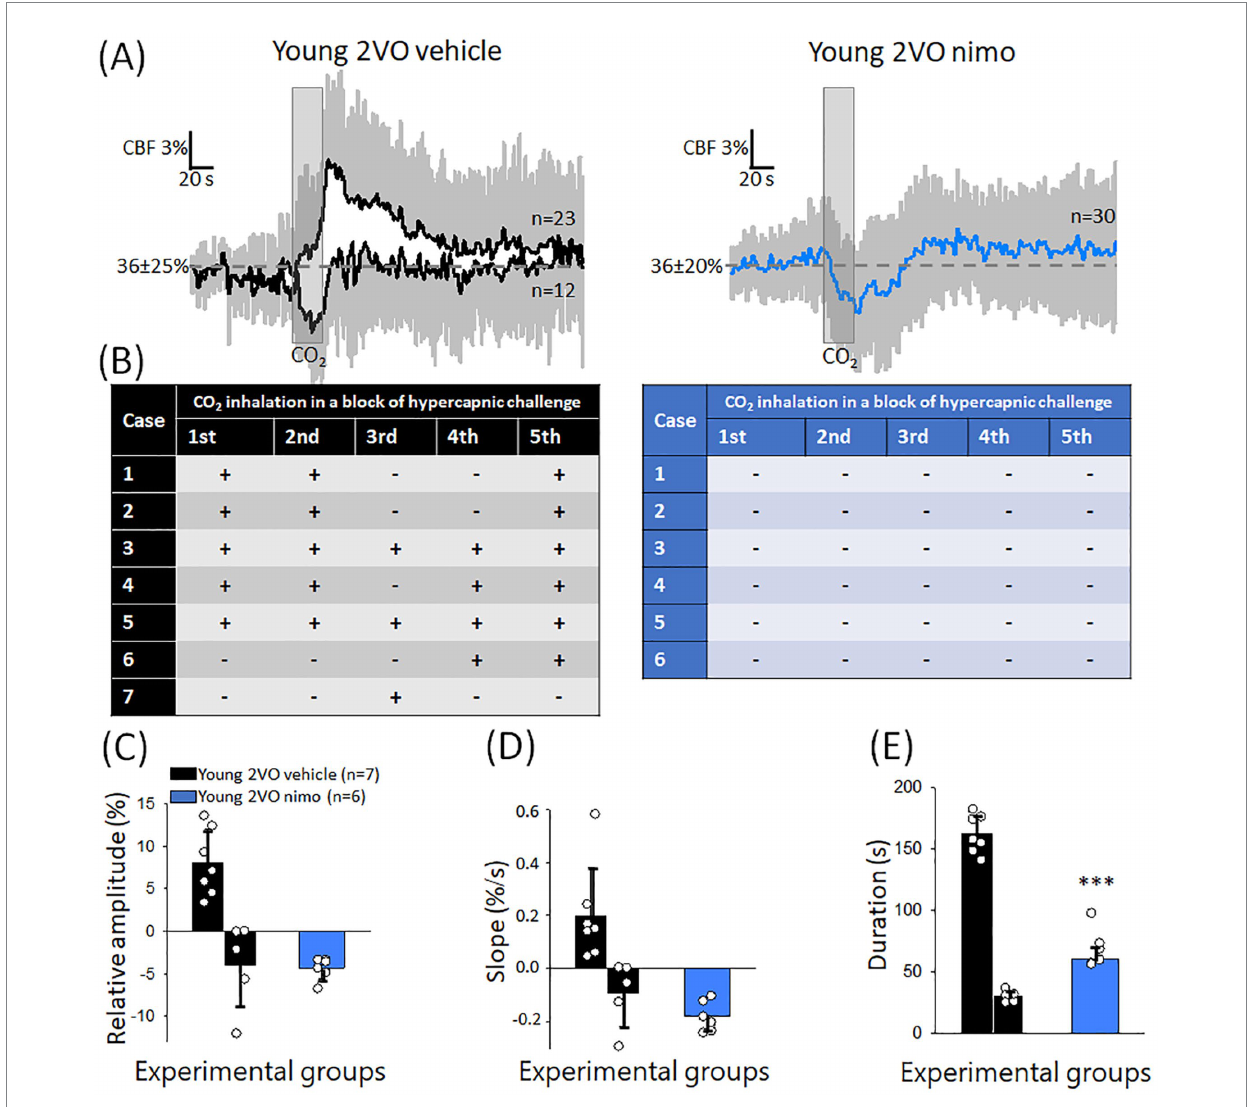
FIGURE 7 The effect of nimodipine treatment on the CBF response to hypercapnia during the acute phase of cerebral ischemia. (A) Mean traces (±stdev) of the CBF response to hypercapnia in Young 2VO vehicle and Young 2VO nimo animals. (B) Tables provide a summary of the occurrence of negative or positive CBF deflections with each CO 2 inhalation trial in a block of hypercapnic challenge in the Young 2VO vehicle group (black) and the Young 2VO nimo group (blue). (C) The relative amplitude of CBF change. (D) The rate of hyperemia evolution (rising slope). (E) The duration of the CBF response. In C-E , data are given as mean ± stdev, and the means of positive and negative CBF responses are plotted apart (distinct bars) in the Young 2VO vehicle group. For statistical comparison in C-D , only the matching, negative values were taken (second bar in the black bar pairs). The normal distribution of data was evaluated with a Shapiro–Wilk test ( C : p = 0.125, D : p = <0.228 E : p = 0.513). One-way ANOVA was then applied, followed by a Holm Sidak post hoc test. Level of significance is shown as p < 0.001*** vs. Young 2VO vehicle, inverse CBF